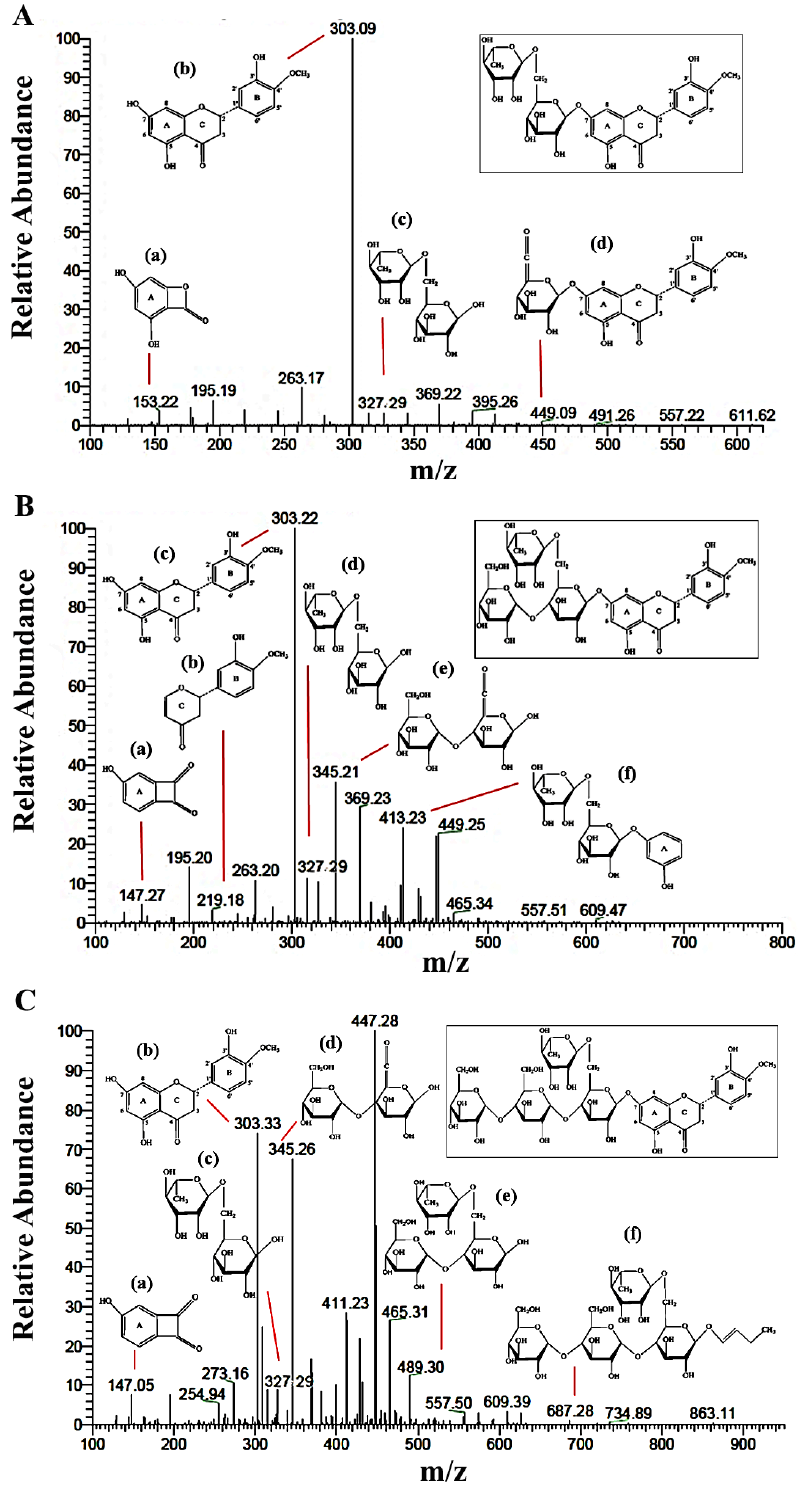
Figure 3. LC-ESI-MS/MS analysis profile in positive mode ionization of the ( A ) hesperidin, ( B ) hesperidin glucoside (HG 1 ) and ( C ) hesperidin maltoside (HG 2 ).